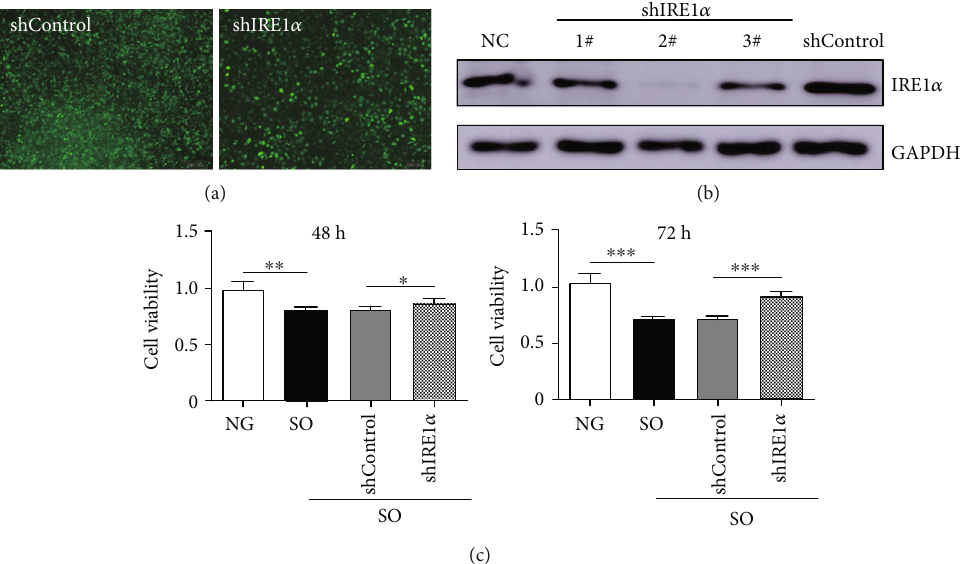
Figure 3: Knockdown of IRE1 α in BRL cells. (a) The representative images of BRL cells transfected with indicated lentivirus. shControl indicated the negative control shRNA and the shIRE1 α was the shRNA targeted shIRE1 α . Scar bar: 50 μ m. (b) The protein expression was detected by western blotting. GAPDH was loaded as an internal control. NC indicated BRL cells not infected with any virus. (c) Cell viability was analyzed by the method of CCK-8 after knockdown of IRE1 α when exposed to SO for 48 h and 72 h, respectively. NG: not given (BRL cells untreated with SO). The data was presented as mean ± SD , ∗ P < 0 : 05 , ∗∗ P < 0 : 01 , ∗∗∗ P < 0 : 001